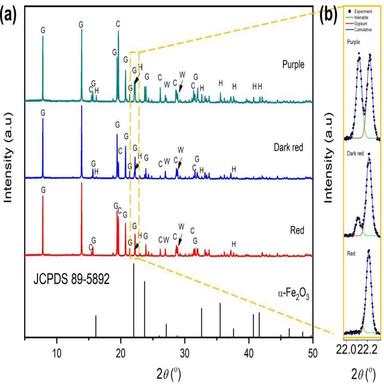
(a) Diffraction Pattern of purple, dark red and red pigments, and (b) Fitting on (104) plane of hematite peak of purple, dark red, red samples. G stands for gypsum, C for calcite, W for whewellite, and H for hematite.